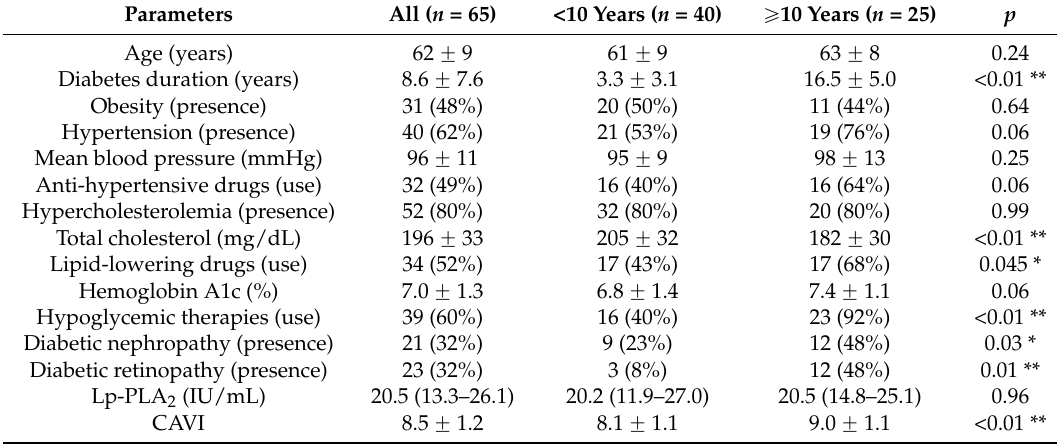
Table 1. Clinical data of the patients according to the diabetes